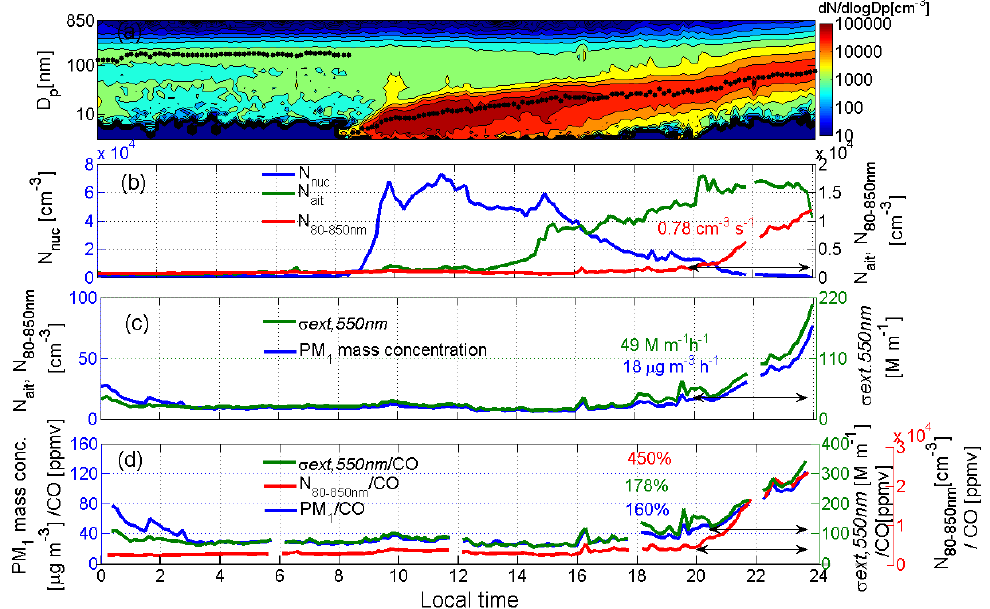
Figure 9. The number size distribution at SDZ on 13 March 2008 and mode diameter (dots) (a), evolution of the N nuc , N ait and N 80-850 nm , respectively (b), evolution of σ ext,550 nm , extinction coefficient at 550 nm and PM 1 mass concentration calculated from TDMPS data (c) and the normalized N 80-850 nm , PM 1 mass concentration and σ ext,550 nm by the concentration of CO.